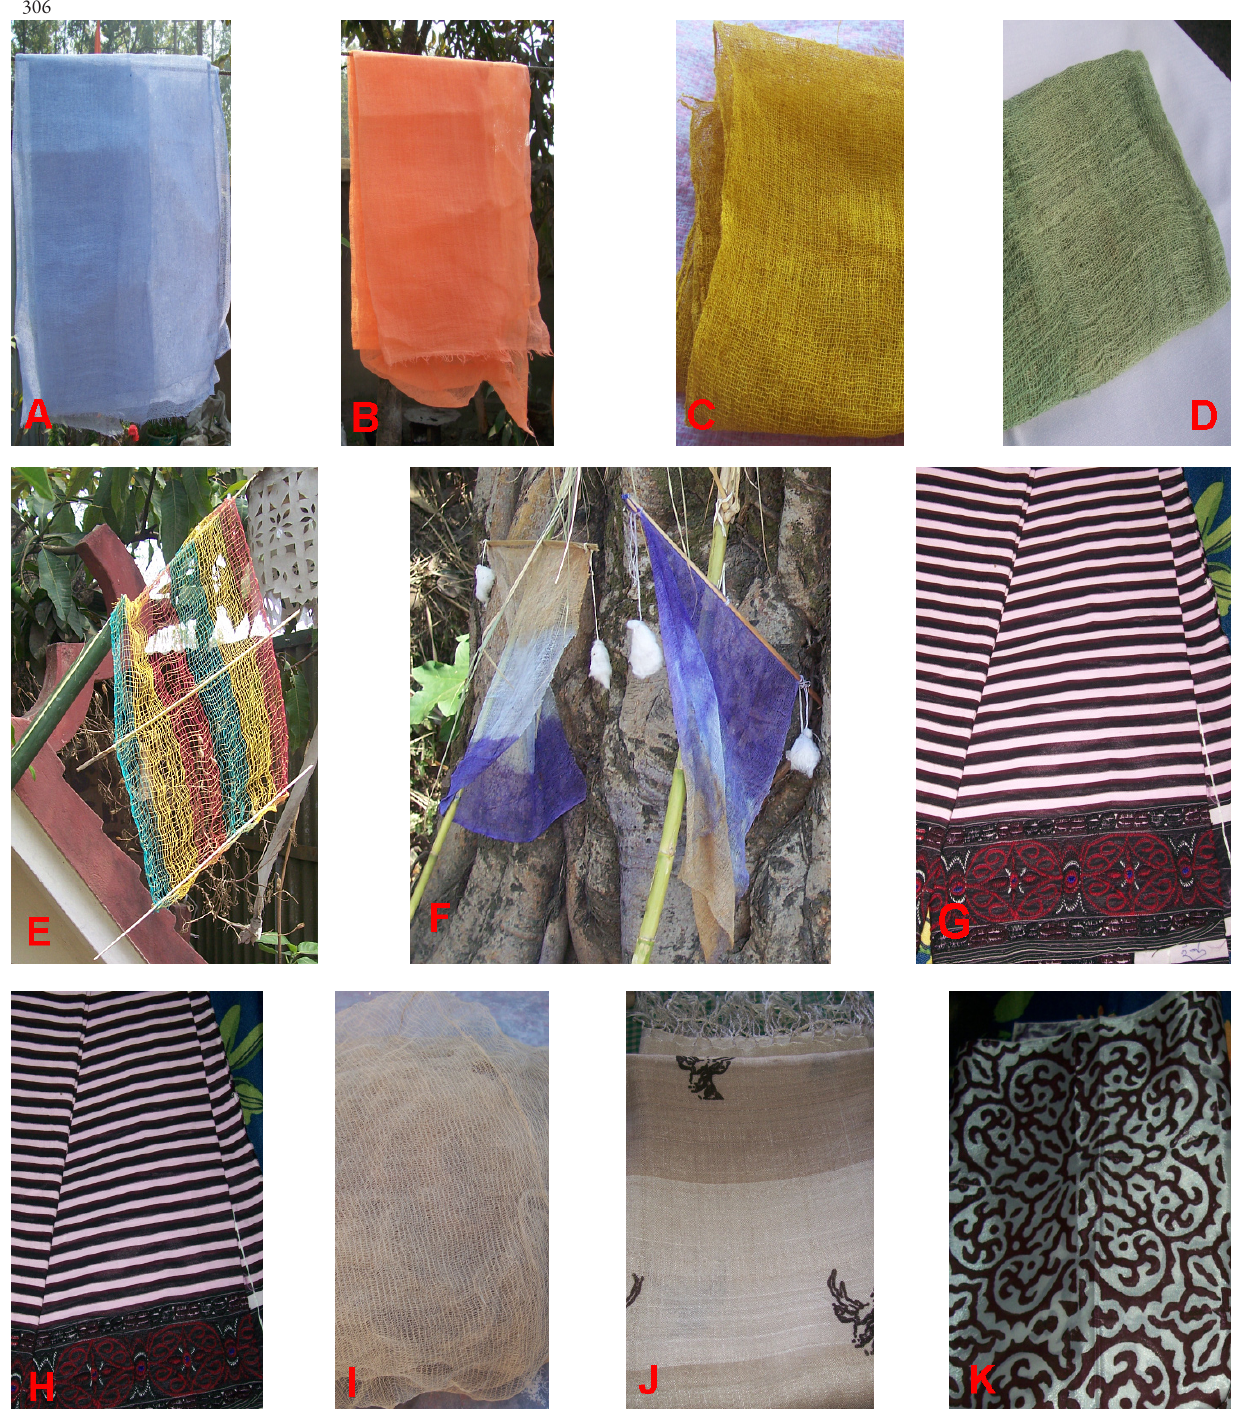
Fig. 3. Different shades and designs of clothes dyed from the ten dye yielding